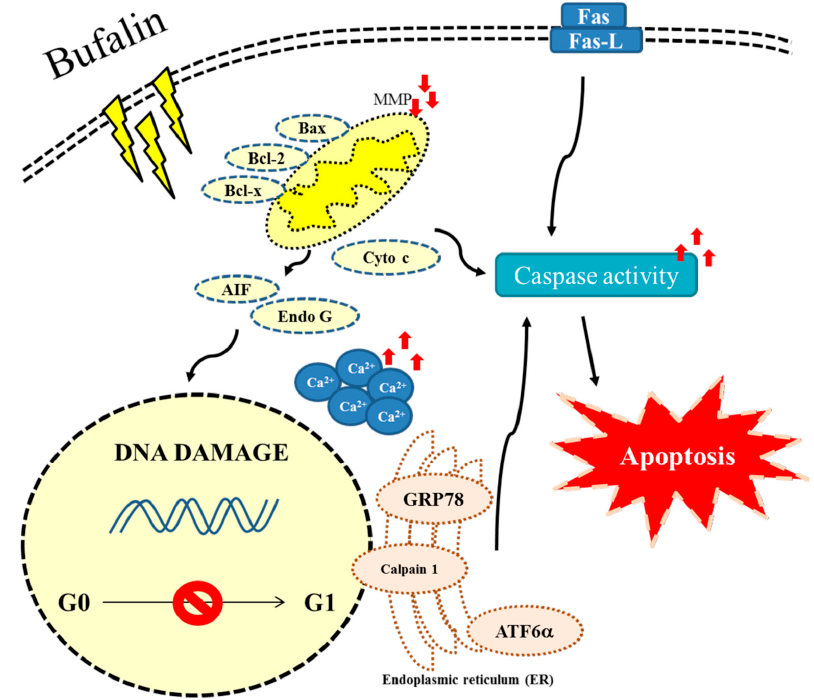
Figure 8. The possible extrinsic and intrinsic signaling pathways for bufalin induced apoptosis in U-2 OS human osteosarcoma cancer cells.